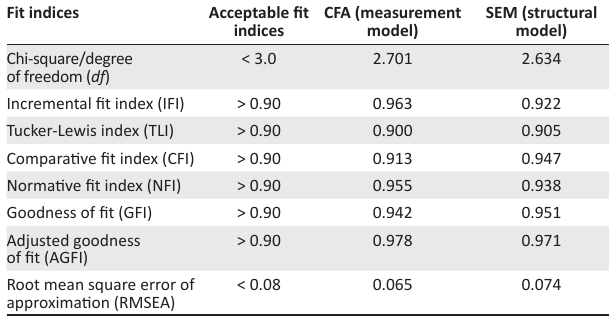
TABLE 3: Model fit statistics.